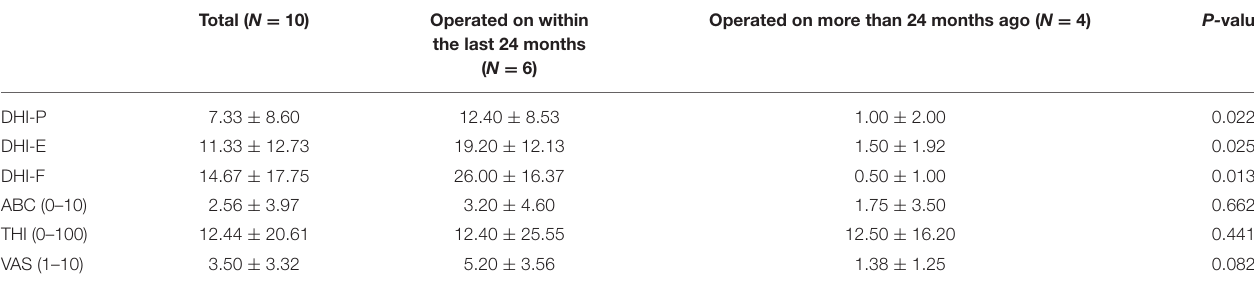
TABLE 4 | Dizziness handicap inventory, activities-specific balance confidence scale, tinnitus handicap inventory, and visual analog scale scores of the triple semicircular canal occlusion patients. Total ( N = 10) Operated on within Operated on more than 24 months ago ( N = the last 24 months